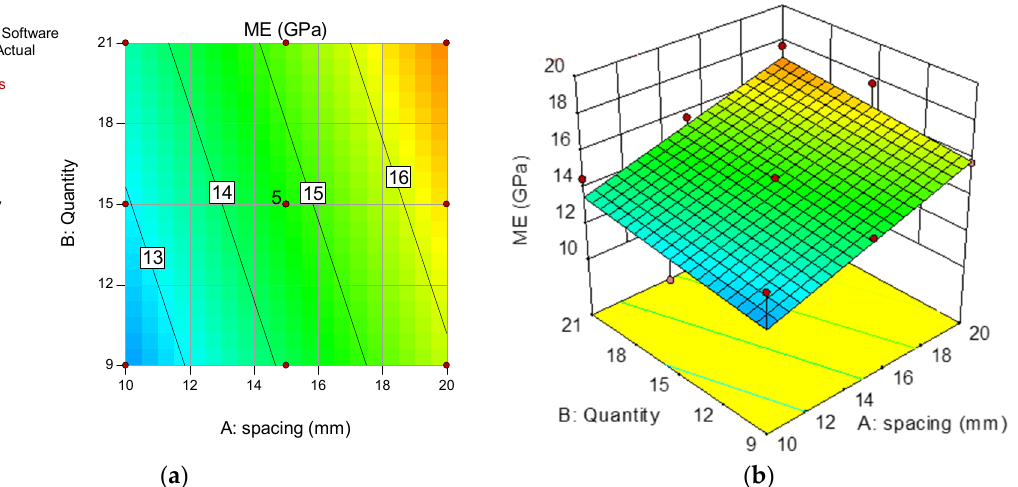
Figure 13. ( a ) Two ‐ dimensional contour plot; ( b ) Three ‐ dimensional response surface diagram for ME model.